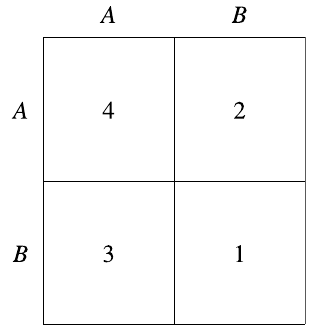
Figure 1. A game where the supreme strategy is strictly